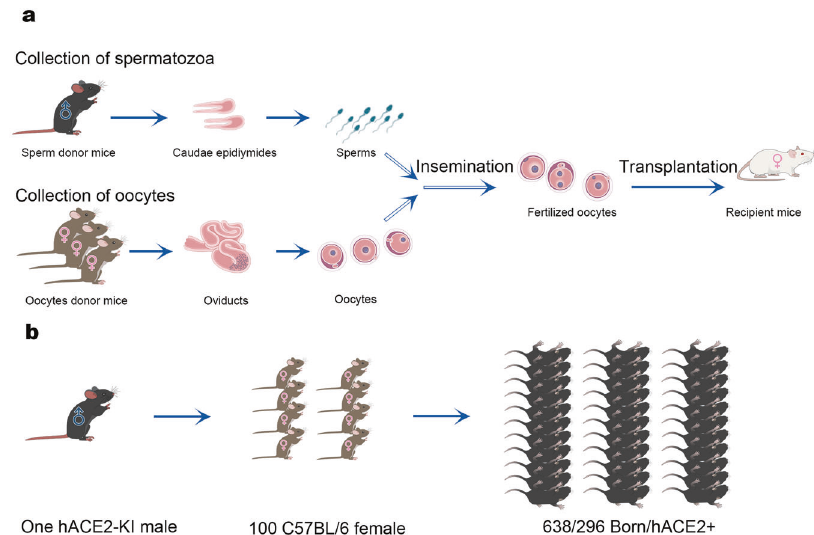
Fig. 2 Rapid breeding of hACE2-KI model mice using in vitro fertilization (IVF) technology. a The main steps of IVF, including a collection of mouse sperm and oocytes, insemination and implantation of fertilized oocytes into recipient foster mice. b A single humanized hACE2-KI mouse and 100 C57BL/6 wild-type mice could produce 638 offspring by IVF technology in a single round, among which 296 hACE2 positive mice were screened by PCR. This rapid breeding technique greatly accelerated the production of humanized hACE2-KI mice